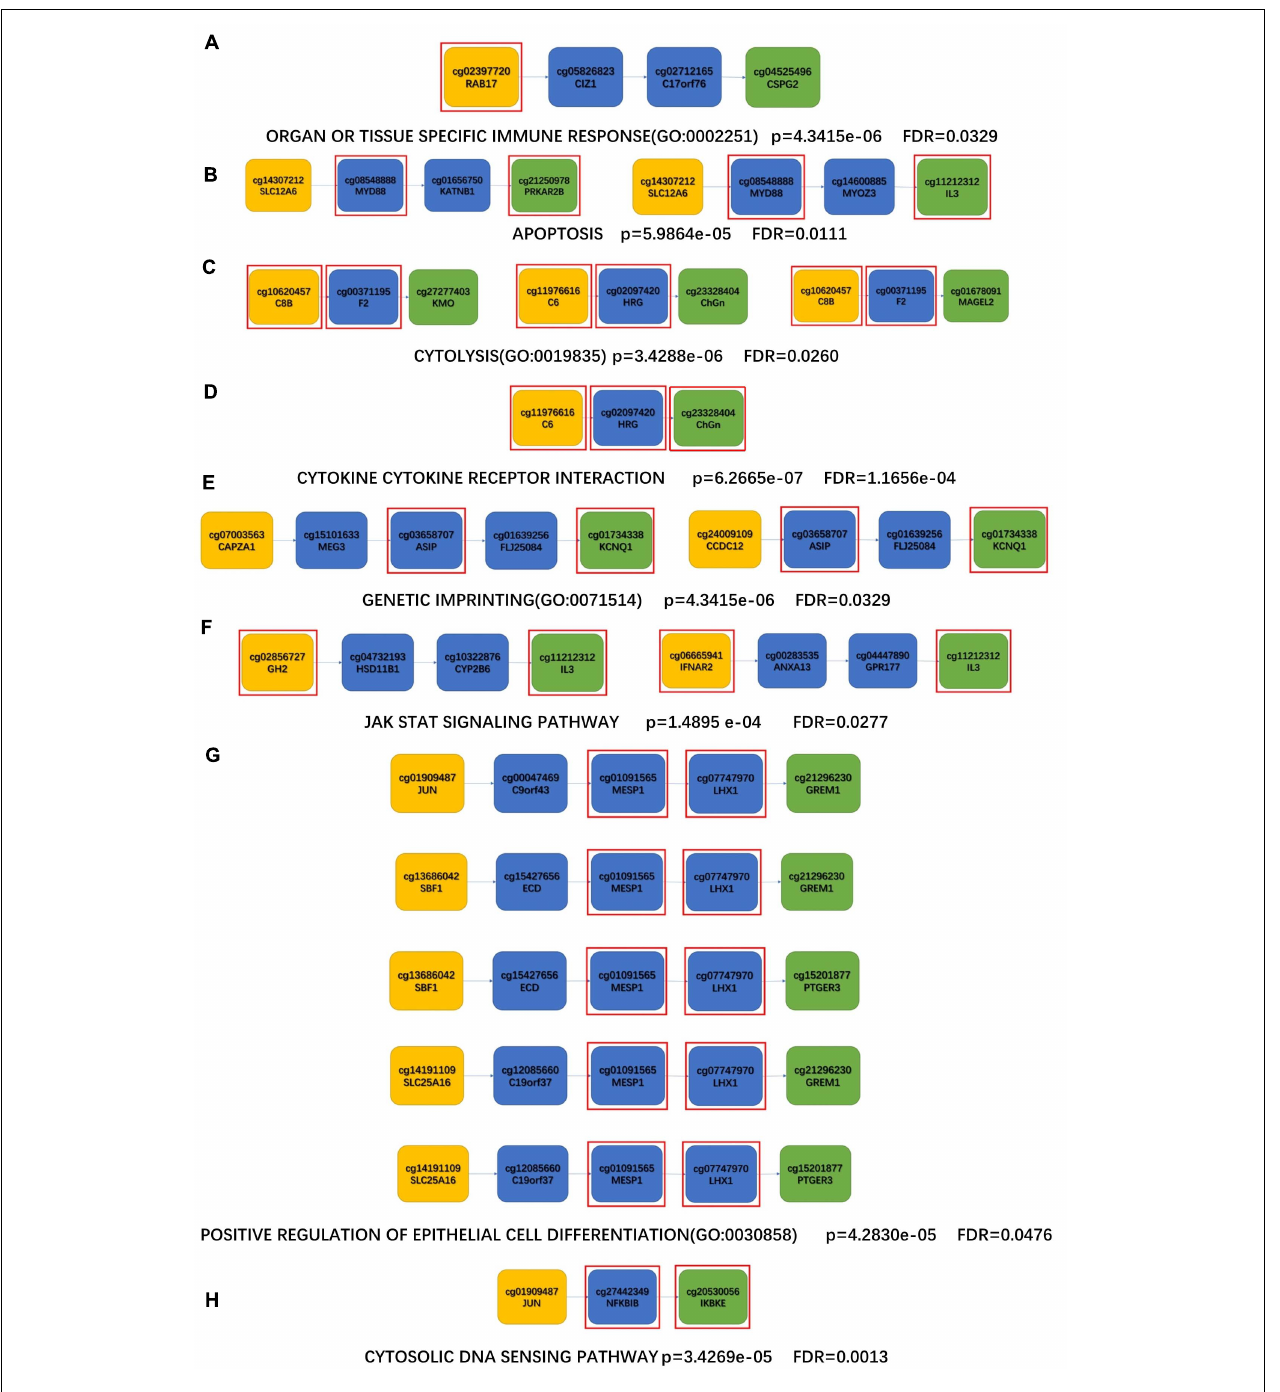
FIGURE 5 | The shortest paths for enrichment analysis of KEGG and BP. (A,B) AD enrichment results; (C,D) PD enrichment results; (E,F) PSP enrichment results; (G,H) FTD enrichment results; (A,C,E,G) enriched KEGG pathway; (B,D,F,H) enriched BP terms; The yellow nodes represent the aging biomarkers, the blue nodes represent the genes connecting aging biomarkers and ND biomarkers, the green nodes represent the ND biomarkers, and the genes in the red square frames coincide with those genes in the enriched functions.